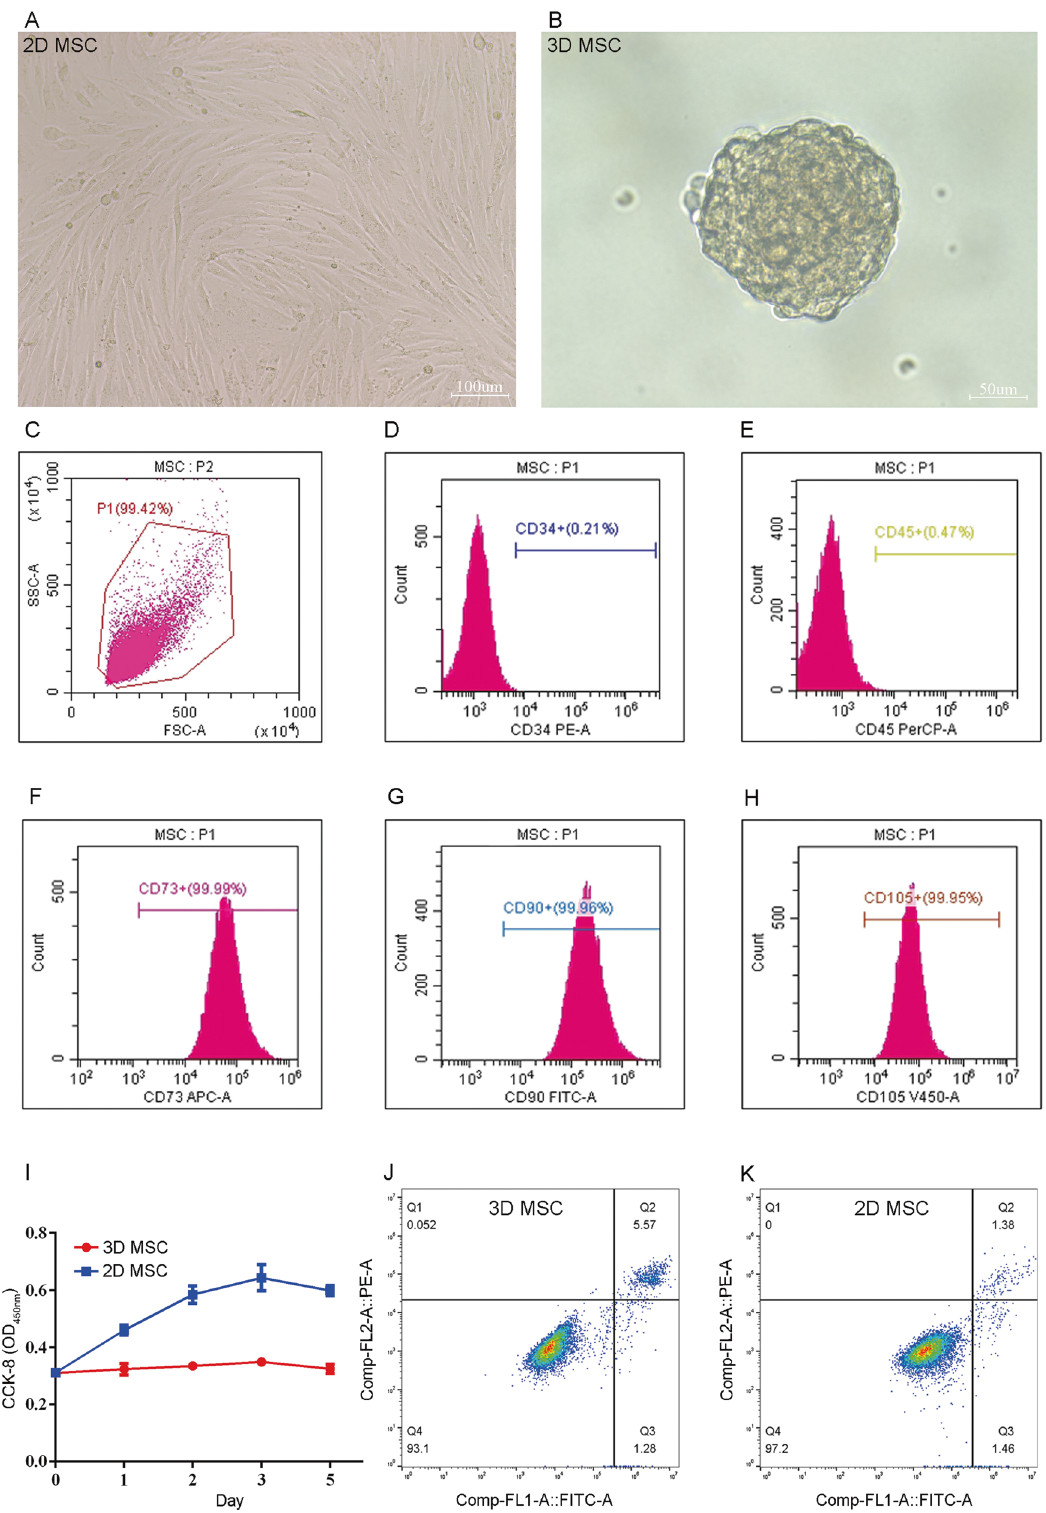
Fig. 1 Isolation and characterization of 2D and 3D-HPMSCs. A, B The morphology of 2D and 3D-HPMSCs. Scale bar, 100 µm ( A ), and 50 µm ( B ) . C The fl ow-activated cytometric sorting. 99.42% MSCs were chosen for cell surface antigen analysis. D – H These selective cells expressed the CD73 ( F ), CD90 ( G ), and CD105 ( H ), but not CD34 ( D ), and CD45 ( E ). I Cells proliferation of 3D-HPMSCs was lower than that of 2D-HPMSCs, P < 0.05. J, K the apoptosis rate of 3D-HPMSCs and 2D-HPMSCs was 5.57% and 1.38%,